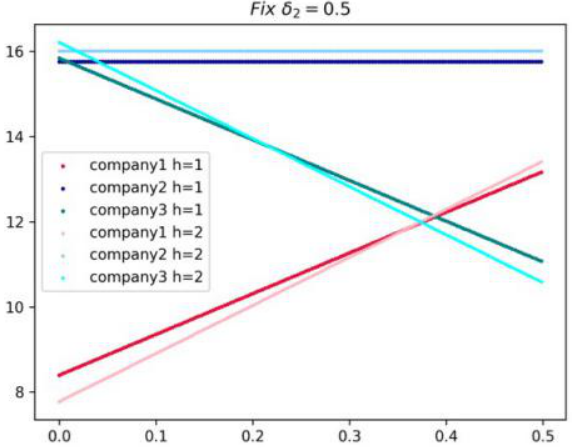
Figure 7. The result of the distribution of profits varies with δ 3 ( δ 2 is fixed).